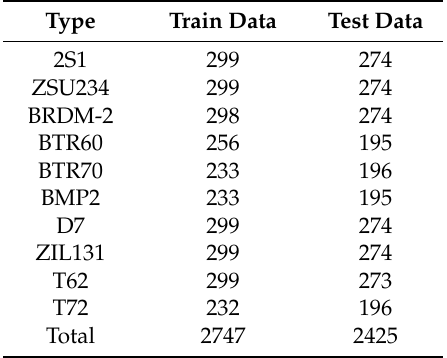
Table 2. The number of images from 10 kinds of targets in the training and test sets.